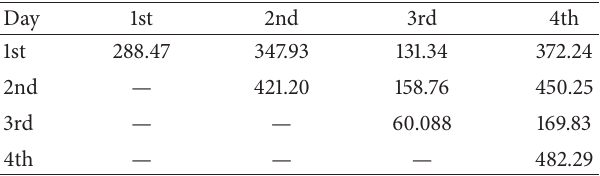
Table 4: Covariance matrix of the two